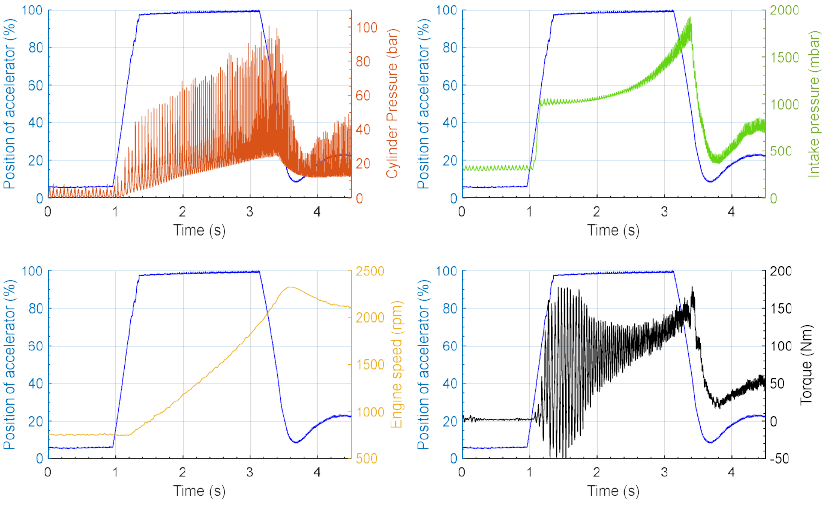
Figure 6. Evolution of engine parameters during a